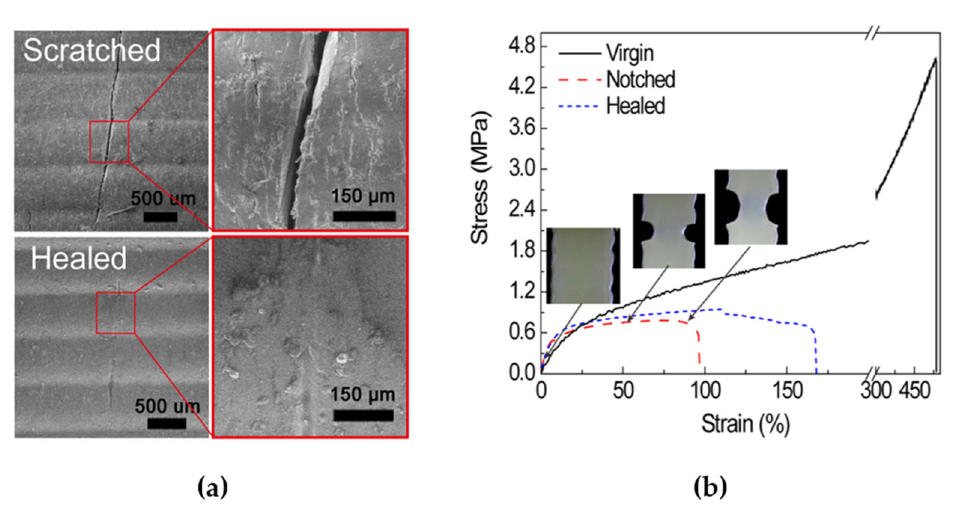
Figure 6. SEM micrographs of self-healing behaviour of printed semi-interpenetrating polymer network elastomer composites show scratched and healed surfaces ( a ). The healing strain was relatively low compared with the virgin sample ( b ). The fracture energy can be calculated by the area under the stress–strain curve. After healing, the fracture energy was increased by 100% (notched sample → healed sample). Therefore, the damage was repaired and some mechanical properties were recovered after healing. Adapted with permission from [82], Copyright 2018 American Chemical Society .